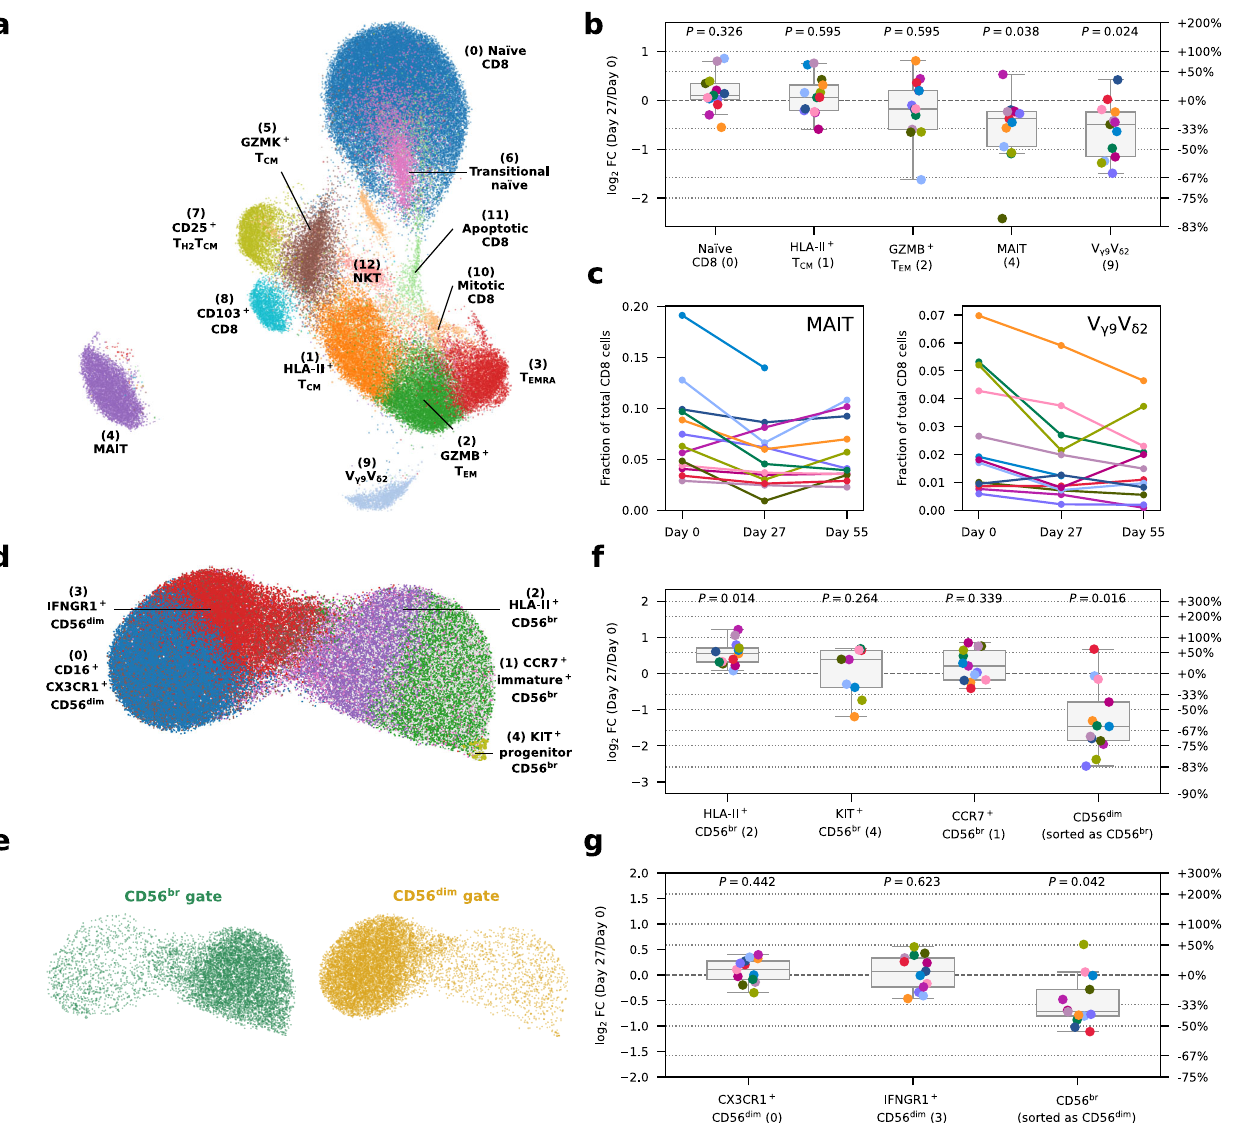
Fig. 4 | IL-2 treatment reduces the frequency of innate-like CD8 + MAIT and V γ 9 V δ 2 T cells in circulation and selectively expands the IL-2 sensitive CD56 br NK cell subset. a UMAP plot depicting the clustering of n =93,379 unstimulated CD8 + T cells. Clusters were manually annotated based on the expression of key mRNA and protein markers. b Relative frequency changes of fi ve selected CD8 + T cell clusters on Day 27 compared to the baseline (Day 0) levels, for unstimulated cells. c Relative frequency of the innate-like mucosal-associated invariant T cell (MAIT;leftpanel)and V γ 9 V δ 2 Tcell(right panel) clusterson Day0,Day27, and Day 55. Each line represents cells from a participant. Lines with the same colour represent the same participant. n =13 participants. d UMAP plot depicting the clustering of n =118,625 unstimulated NK cells. Clusters were manually annotated based on the expression of key mRNA and protein markers. e UMAP plot as in ( d ), split and coloured by FACS sorting gates of origin. f , g Relative frequency changes